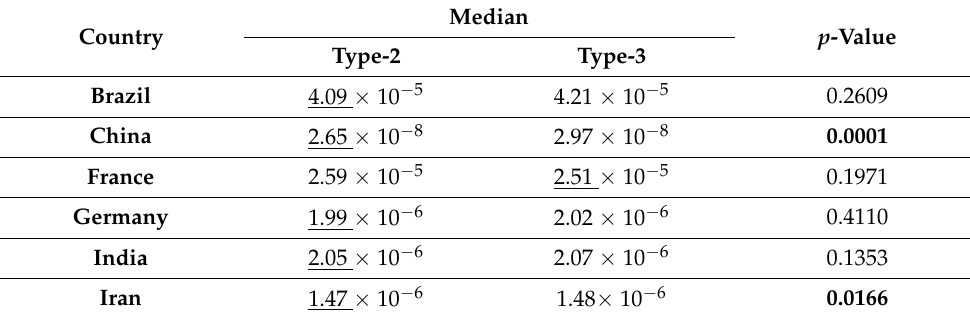
Table 18. Mann–Whitney results (second data period, testing